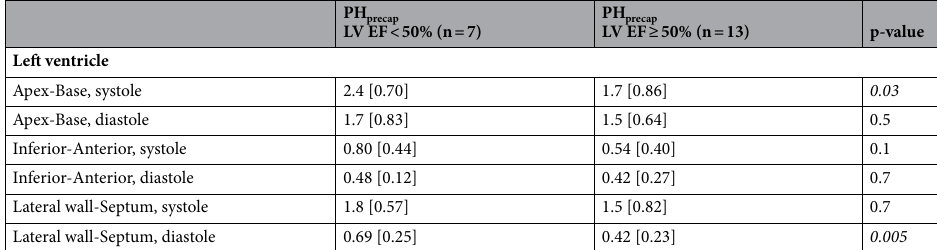
Table 5. Left ventricular hemodynamic forces indexed to stroke volume (N/l) for patients with PH precap grouped by ejection fraction. Significant values are in [italics]. Root mean square left ventricular (LV) hemodynamic forces indexed to LV stroke volume (SV) in patients with precapillary pulmonary hypertension (PH preap ) and controls. Data is expressed as median